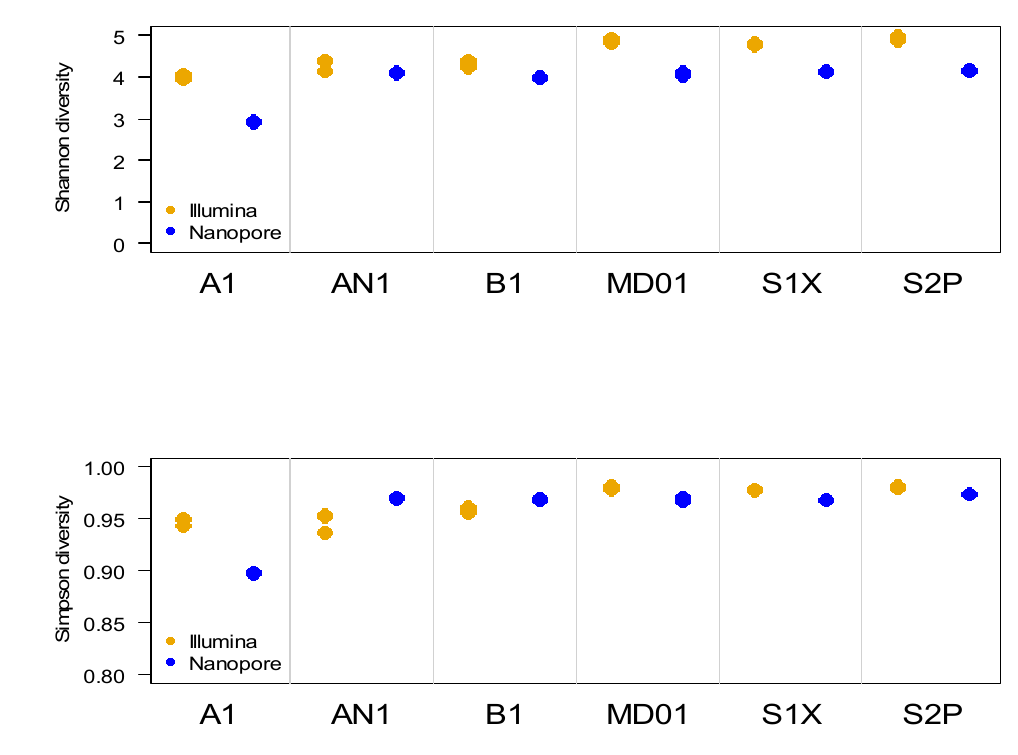
Figure 1. Shannon and Simpson diversity in the faecal samples.